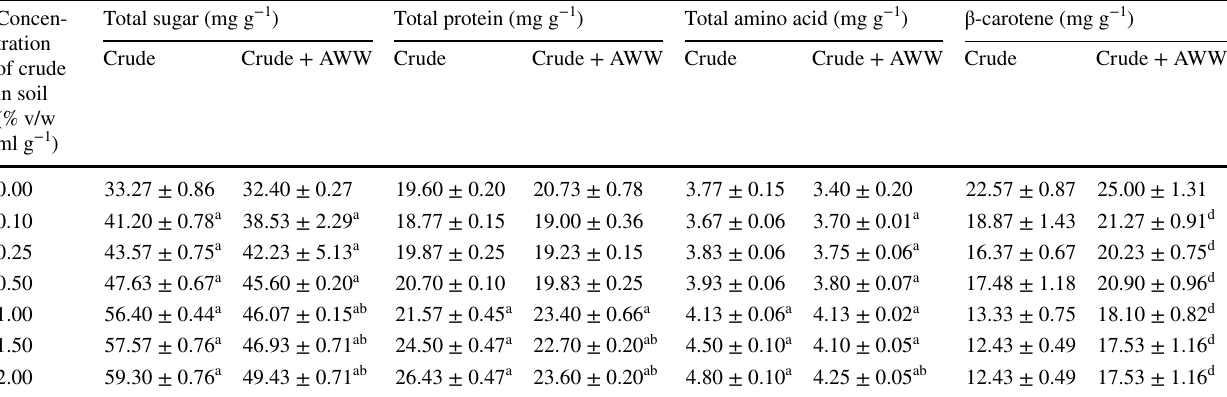
Table 2 Effect of abattoir wastewater treatment on the level of sugar, protein, amino acid and β-carotene in cowpea seedlings exposed to crude oil treated